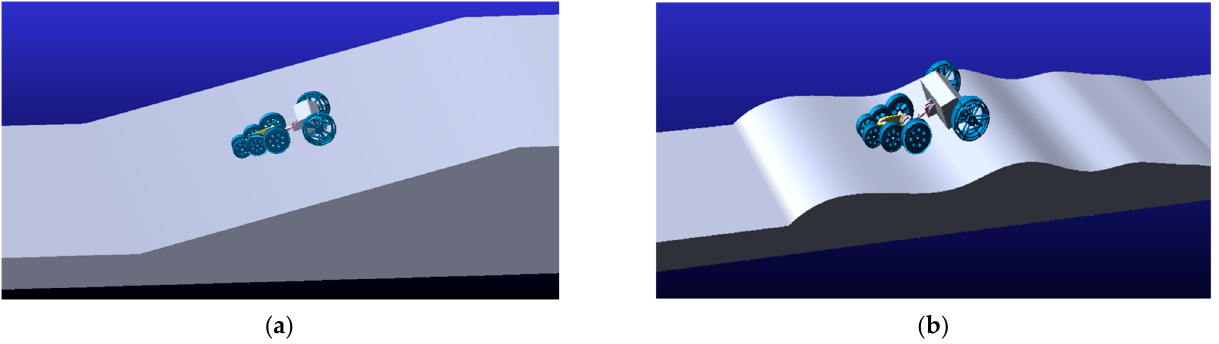
Figure 17. ADAMS simulation diagram. ( a ) Simulation drawing of moving in a sloped terrain; ( b ) simulation drawing of crossing a complex road surface.